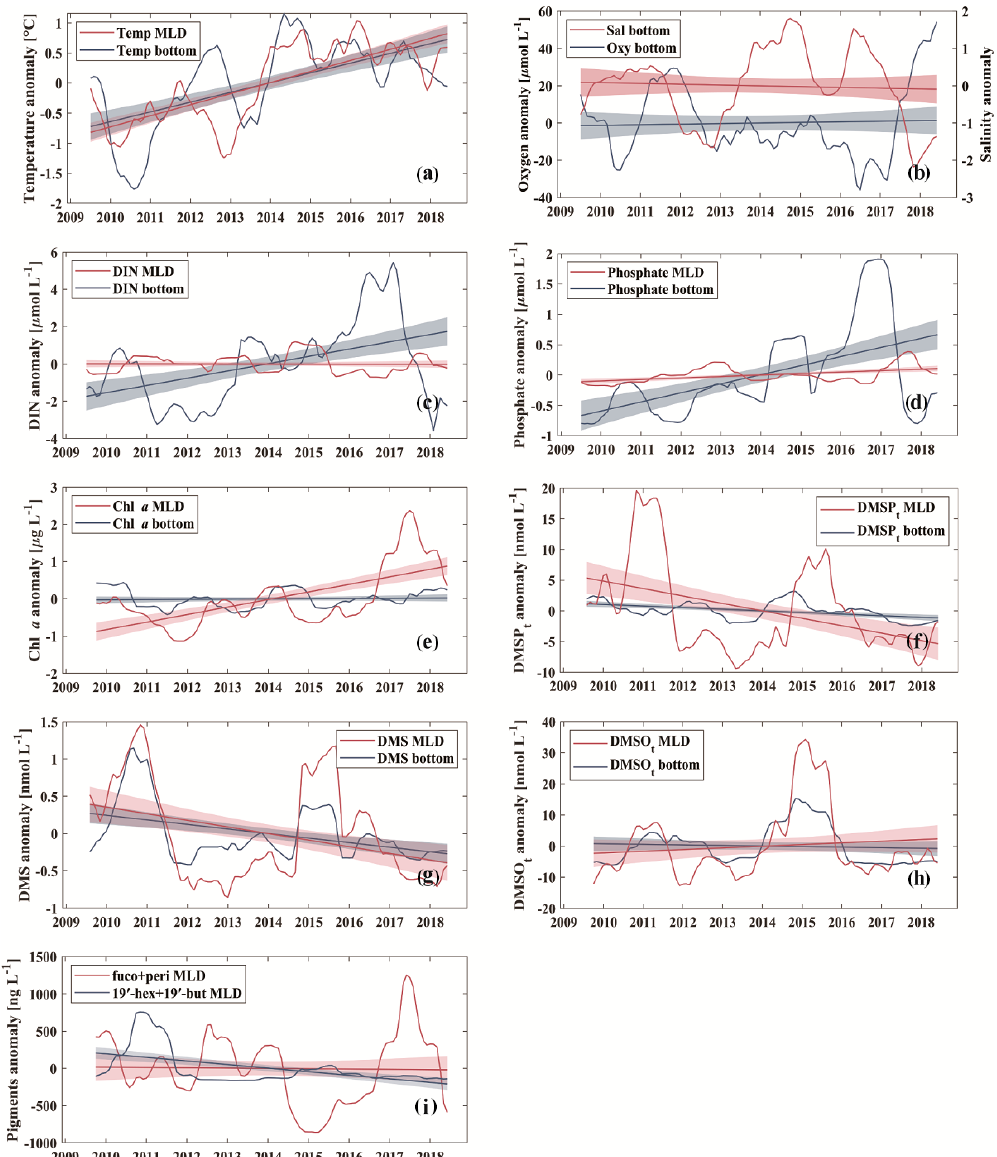
Figure 4. Temporal trends of anomalies of temperature ( ◦ C) (a) , dissolved oxygen (µmolL − 1 ) and salinity (b) , dissolved inorganic nitrogen (DIN; µmolL − 1 ) (c) , phosphate (µmolL − 1 ) (d) , Chl a (µgL − 1 ) (e) , DMSP t (nmolL − 1 ) (f) , DMS (nmolL − 1 ) (g) , DMSO t (nmolL − 1 ) (h) , and the sum of pigment concentrations of fucoxanthin (fuco) and peridinin (peri) (ngL − 1 ) and 19 (cid:48) -hexanoyloxyfucoxanthin (19 (cid:48) -hex) and 19 (cid:48) -butanoyloxy-fucoxanthin (19 (cid:48) -but) (ngL − 1 ) (i) . The shaded areas indicate 95% confidence intervals. Note that gaps were filled by linear interpolation in the case of one or two missing months in a row, and large gaps between August and December 2009 in DMSO t (h) were filled by replacement with the median of the corresponding